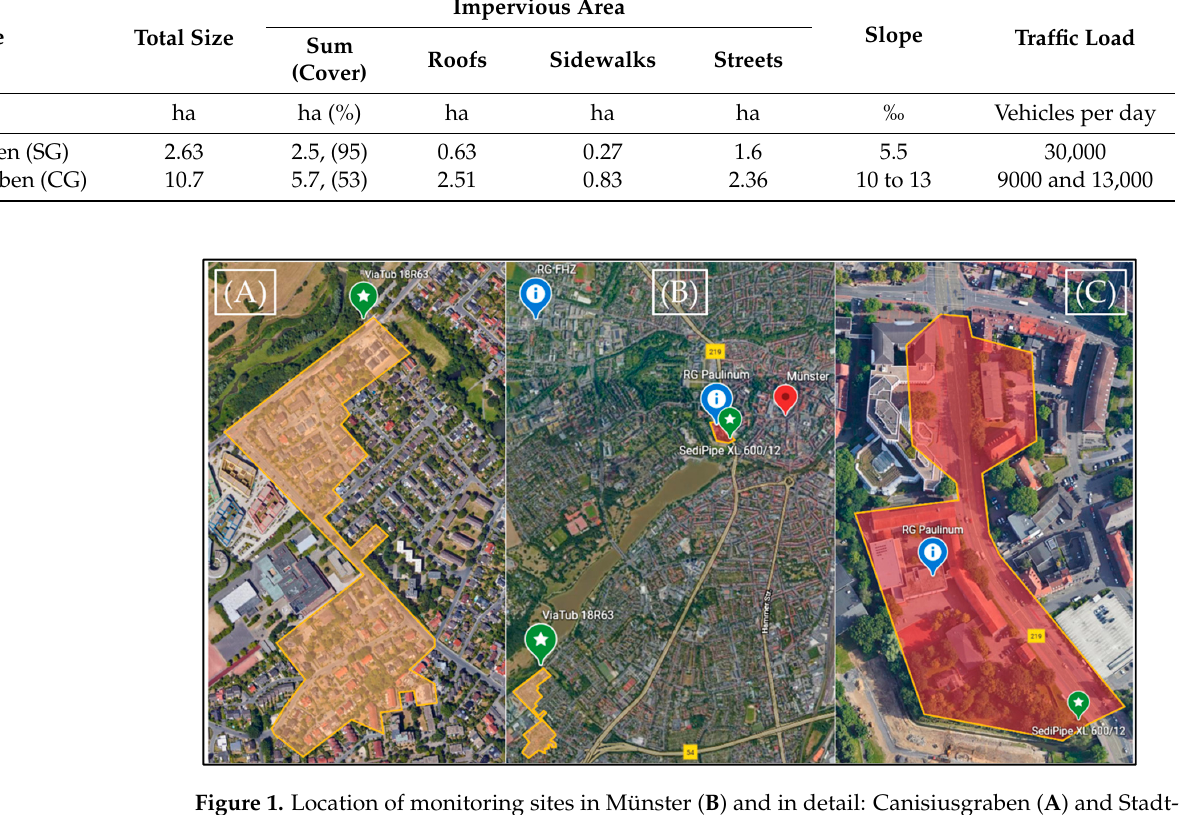
Figure 1. Location of monitoring sites in Münster ( B ) and in detail: Canisiusgraben ( A ) and Stadt- graben ( C ), with decentralized stormwater treatment systems (DS) positions (green marks), rain gauge (RG) positions (blue infopoint marks), and sewer catchment (orange and red framed areas). (Image © 2021 Google Earth).